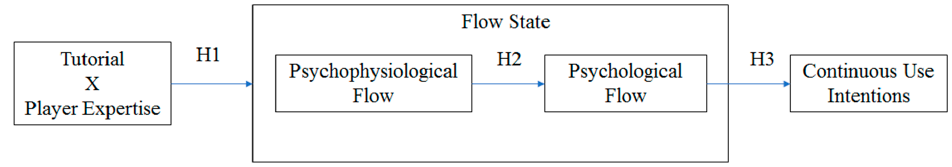
Figure 1. Conceptual model and hypotheses.